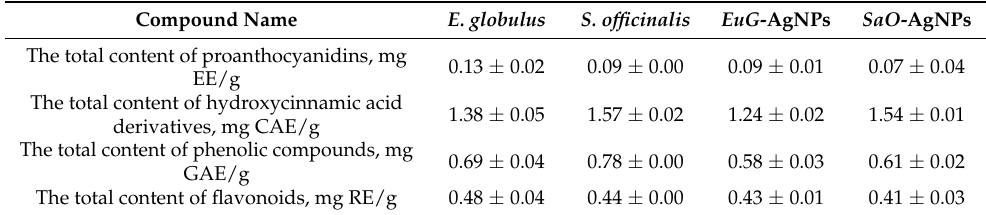
Table 1. Phytochemical analysis of plant extracts and biosynthesized